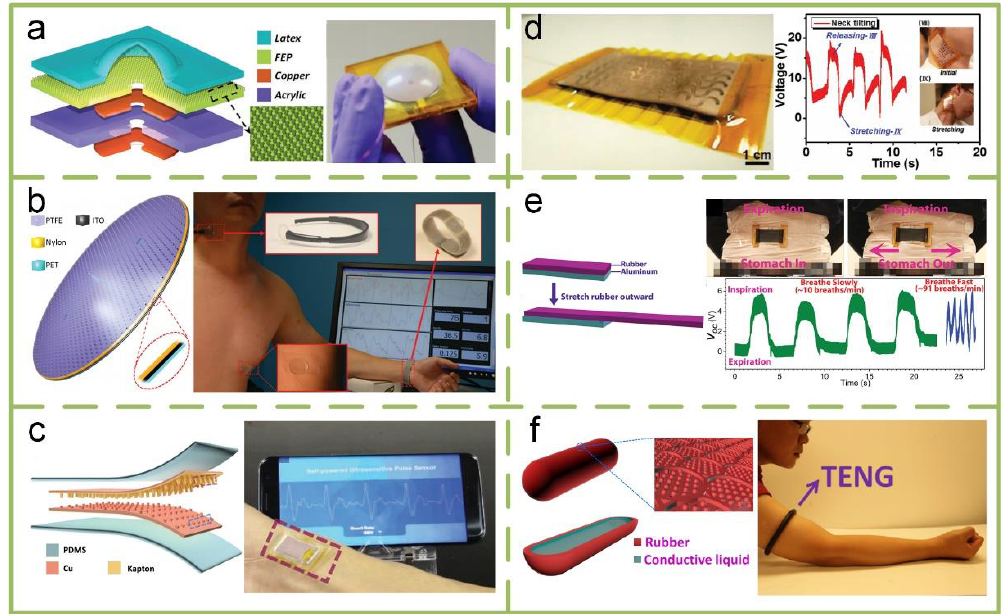
Figure 12. External pasting TENGs for biomedical and healthcare applications. ( a ) Membrane-based self-powered triboelectric sensors for pressure change detection. Reproduced with permission [137].